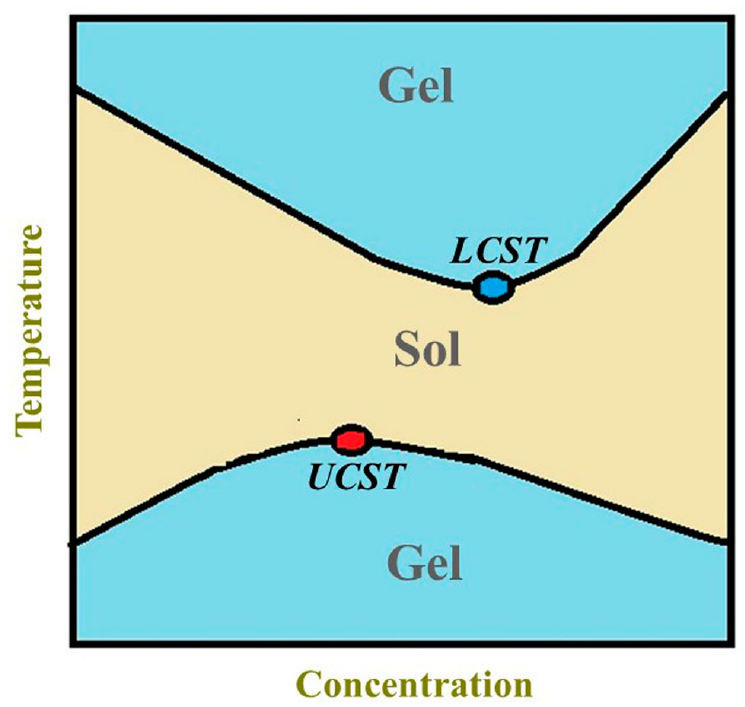
Figure 2. LCST-type formulation undergoes sol–gel transition with increase in temperature while UCST-type formulation undergoes sol–gel transition as the temperature decreases. The black colored curved lines indicate the boundary of phase separation.